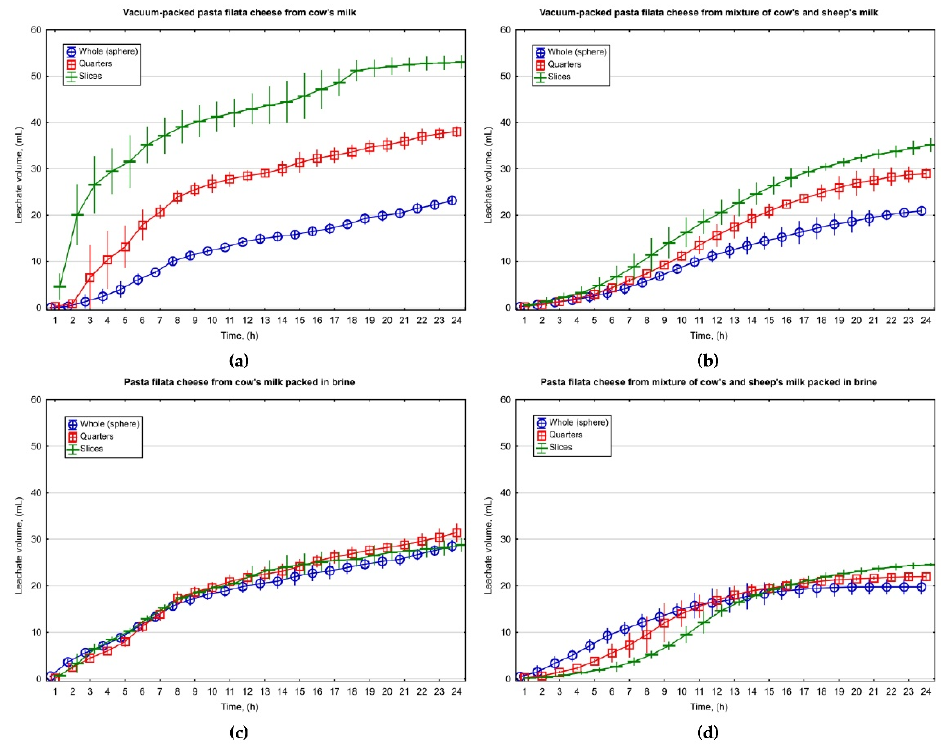
Figure 4. The amount of water–fat serum released from fresh pasta filata cheese made from cow’s milk ( a , c ) and its mixture with sheep’s milk ( b , d ) within 24 h after unpacking depending on the degree of sample fragmentation and packaging method.